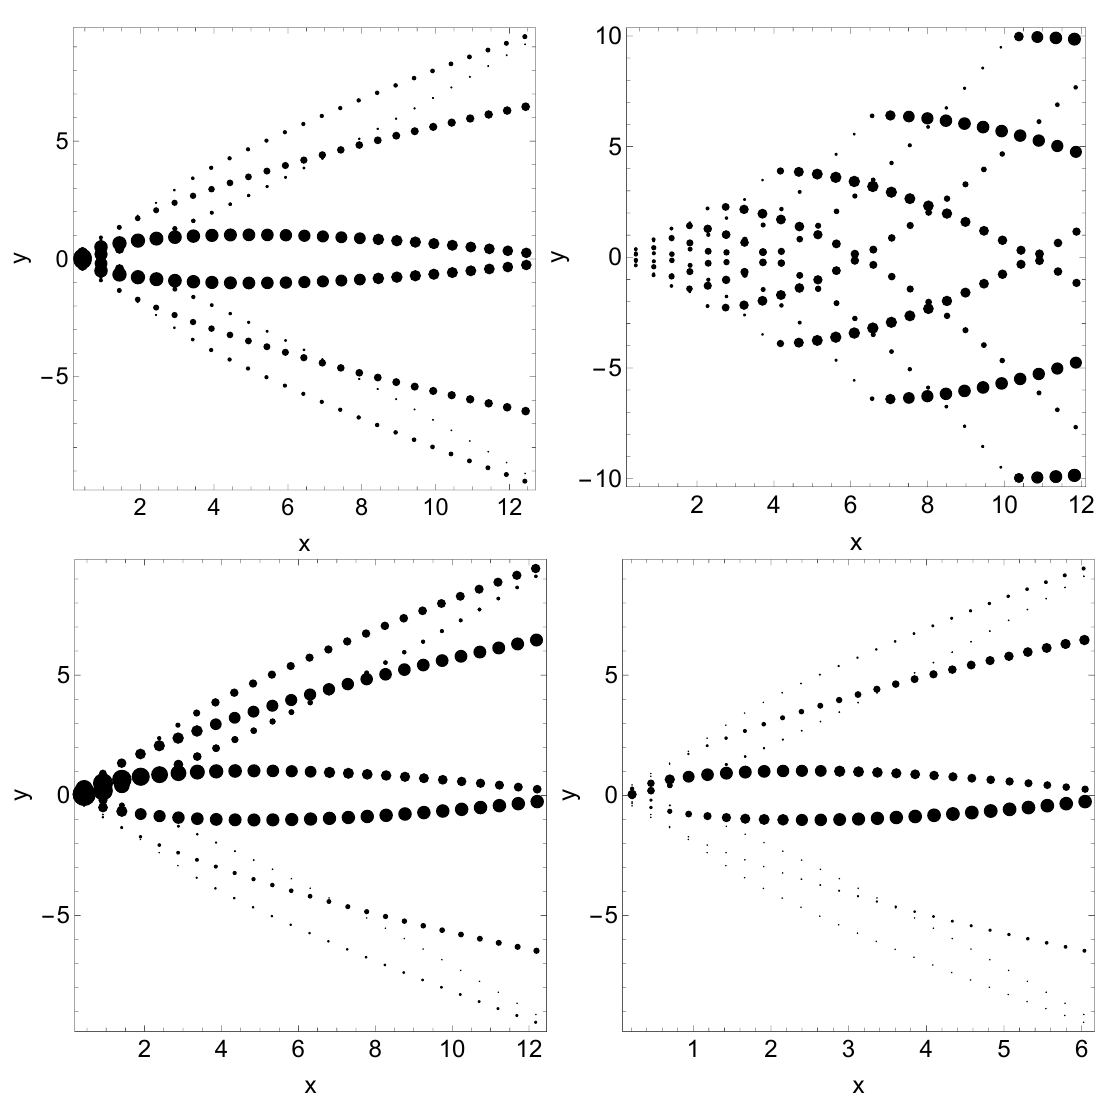
Figure 4. Examples of knot trajectories. Each panel shows 8 trajectories, corresponding to launching moments separated by an eighth of a period. The size of the circles is proportional to δ 4 (normalization is different in different panels). Projection of the central axis of the jet onto the plane of the sky is along x axis. Position of the knots are plotted for a fixed interval of the coordinate time (not observer time). Top row: θ ob = 1/10, φ ob = 0, M j = 50, γ j = 17 (top left) and M j = 10, γ j = 3.7 (top right). Bottom left panel: θ ob = 1/10, φ ob = 1/5, γ j = 17, bottom right panel: θ ob = 1/20, φ ob = 1/4, γ j = 17 ( M j is the Mach number of the jet in terms of the pattern